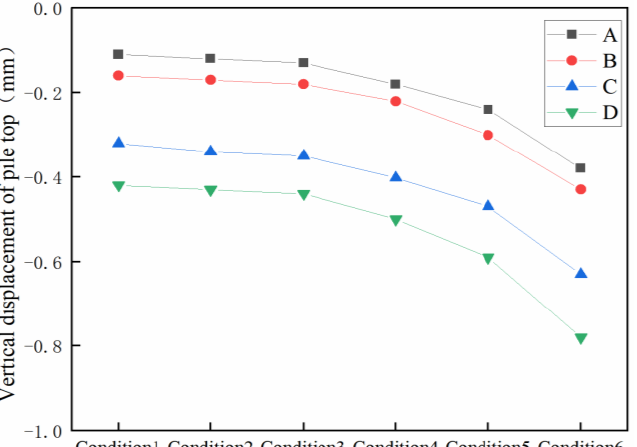
Figure 15. Deformation curve of pile top under different working conditions: A, B , C, and D are the top of different piles in Figure 8.